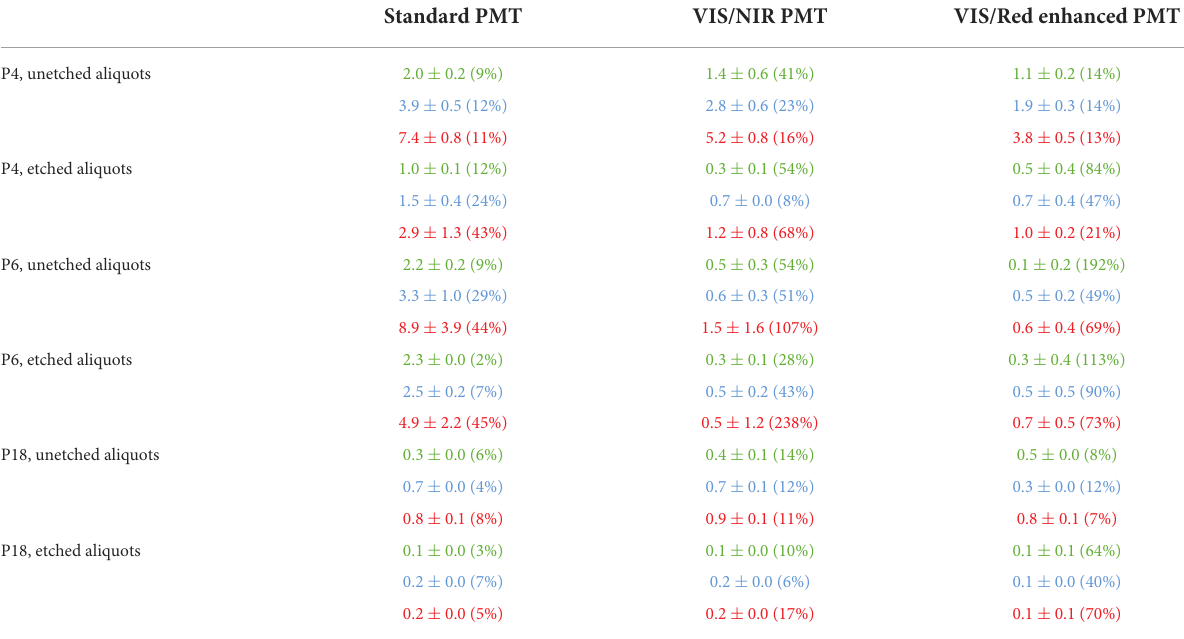
TABLE 3 Comparison of results obtained using three detection systems. Screen protector ID Mean estimated intrinsic background doses ± SD (Gy) for different detection